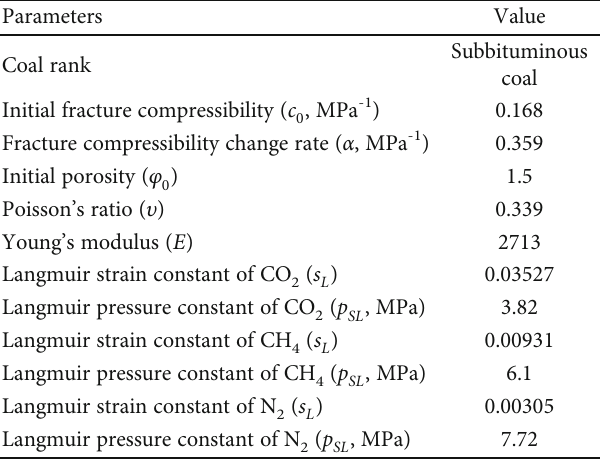
Figure 29: The relationship between injection capacity of CO in elastic modulus. Table 7: Parameters used to the original R-C